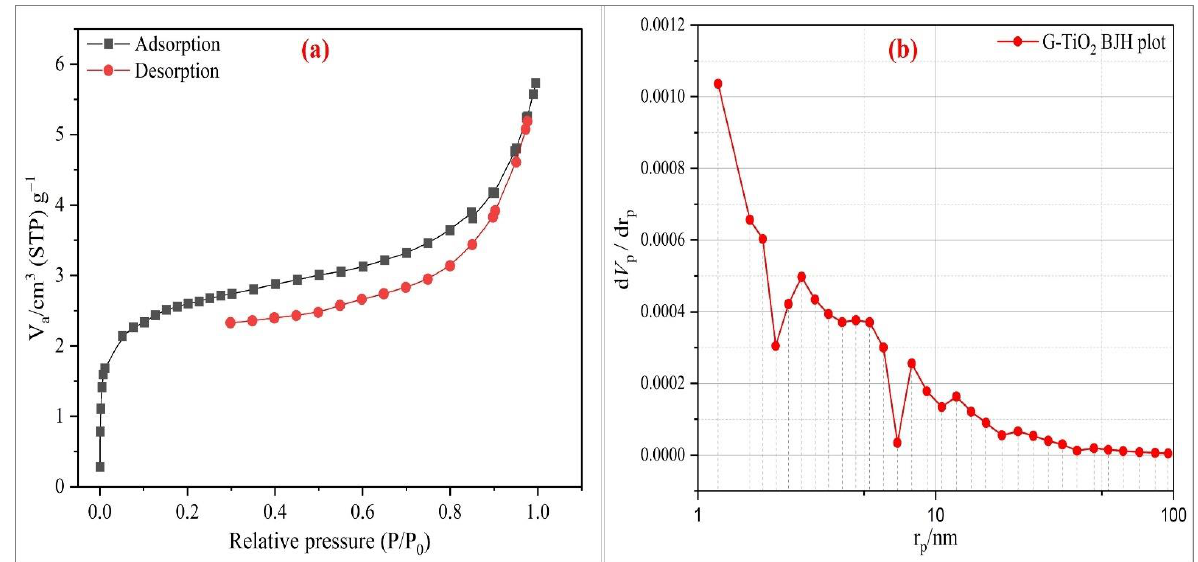
Figure 6. BET analysis. ( a ) Adsorption-desorption spectra; ( b ) BJH pore size distribution plots of biosynthesized TiO 2 nanoparticles.